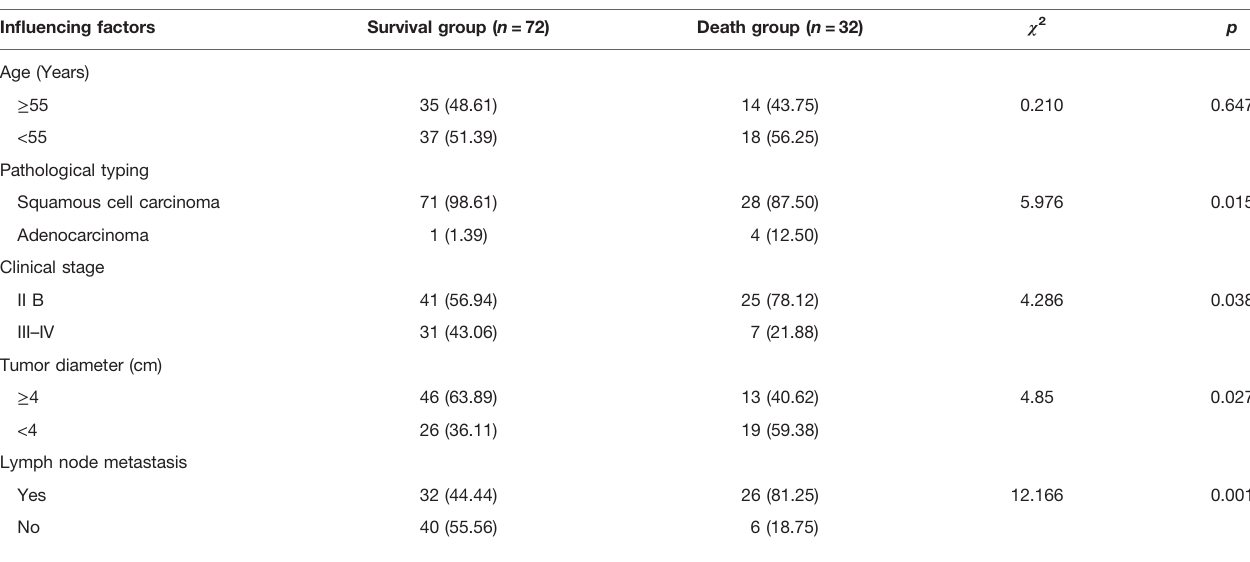
TABLE 3 | Analysis of prognostic factors of patients with medium-term and advanced cervical cancer ( n , %).